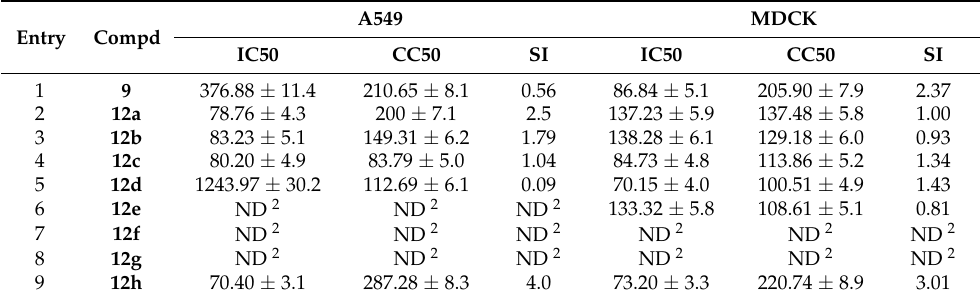
Table 3. IC50, CC50 values and selective index (SI) of belladine N -oxides derivatives 9 and 12a – h